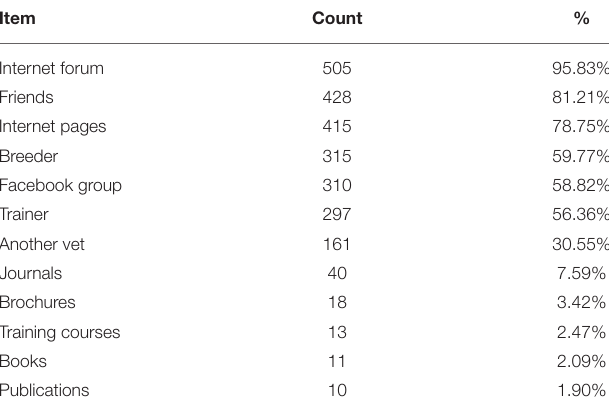
TABLE 3 | Frequencies of the questionnaire items related to the sources of self-information from a survey of 527 German